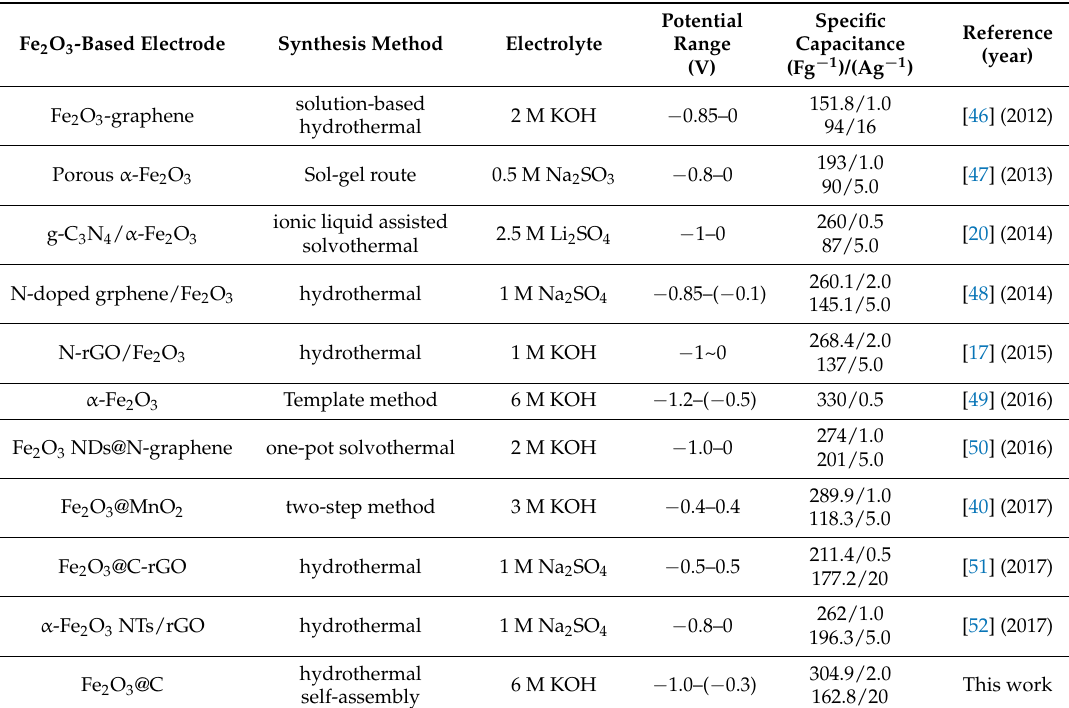
Table 1. Comparison of Fe 2 O 3 -based electrode reported in recent literature using three-electrode system for supercapacitor